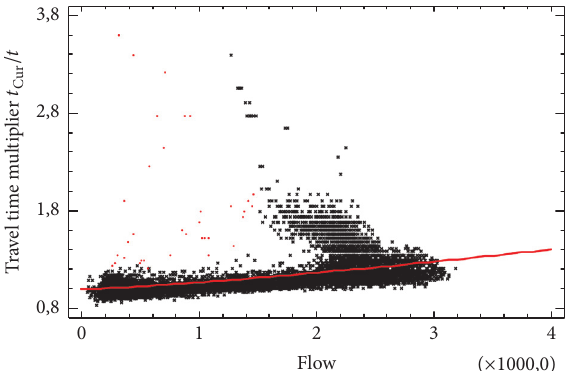
Figure 5: Travel time multiplier [—] against hourly flow [veh/h] and the BPR function estimated for this data (red) with output parameters equal to 𝑎 ≈ 1 and 𝑏 = 1.27